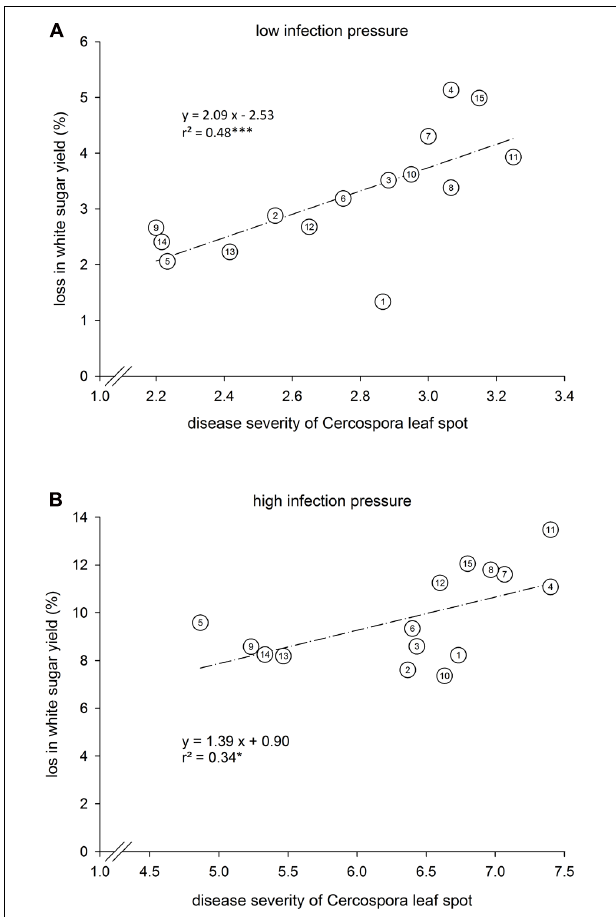
FIGURE 3 | Disease severity of Cercospora leaf spot (CLS) and relative loss of white sugar yield (WSY) in 15 sugar beet varieties tested at (A) 30 environments with low infection with CLS and (B) 15 environments with high infection with CLS; Germany, 2014–2016 under high infection in the non-treated level. Relative loss in WSY is the yield difference between healthy and non-treated fungicide levels as percentage of WSY in the healthy level. DS was rated in the non-treated plots on a 1–9 scale (1: no infection, 9: very high infection; BSA, 2000). ∗ P ≤ 0.05 and ∗∗∗ P ≤ 0.001.